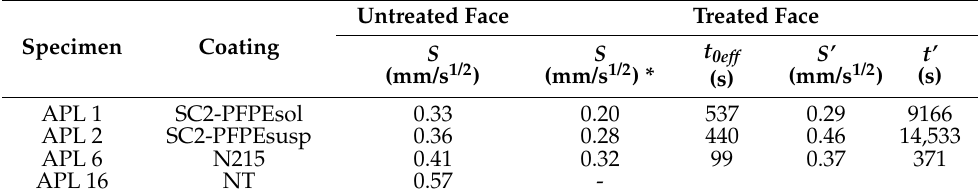
Table 5. Sorptivity for coated and uncoated Lecce stone